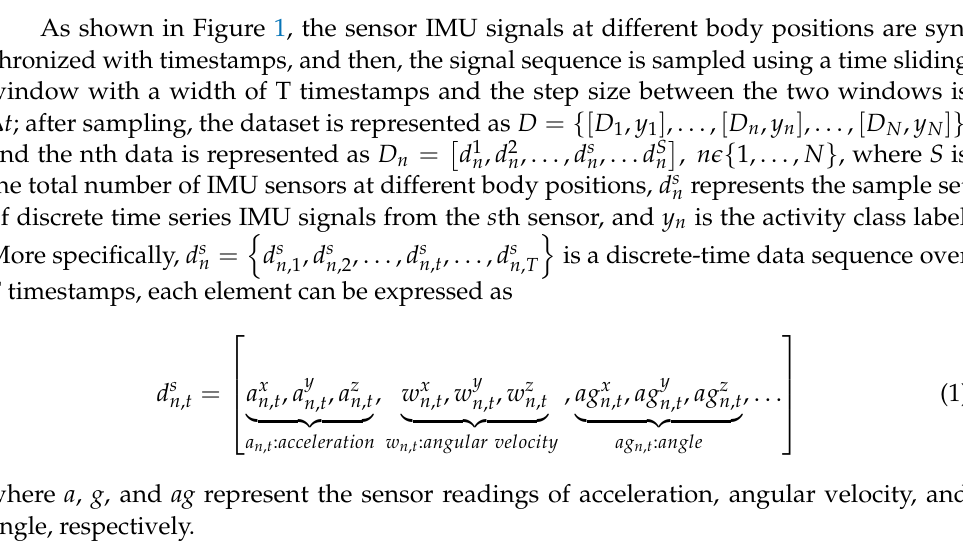
Figure 1. Activity recognition network architecture based on deep ensemble learning.